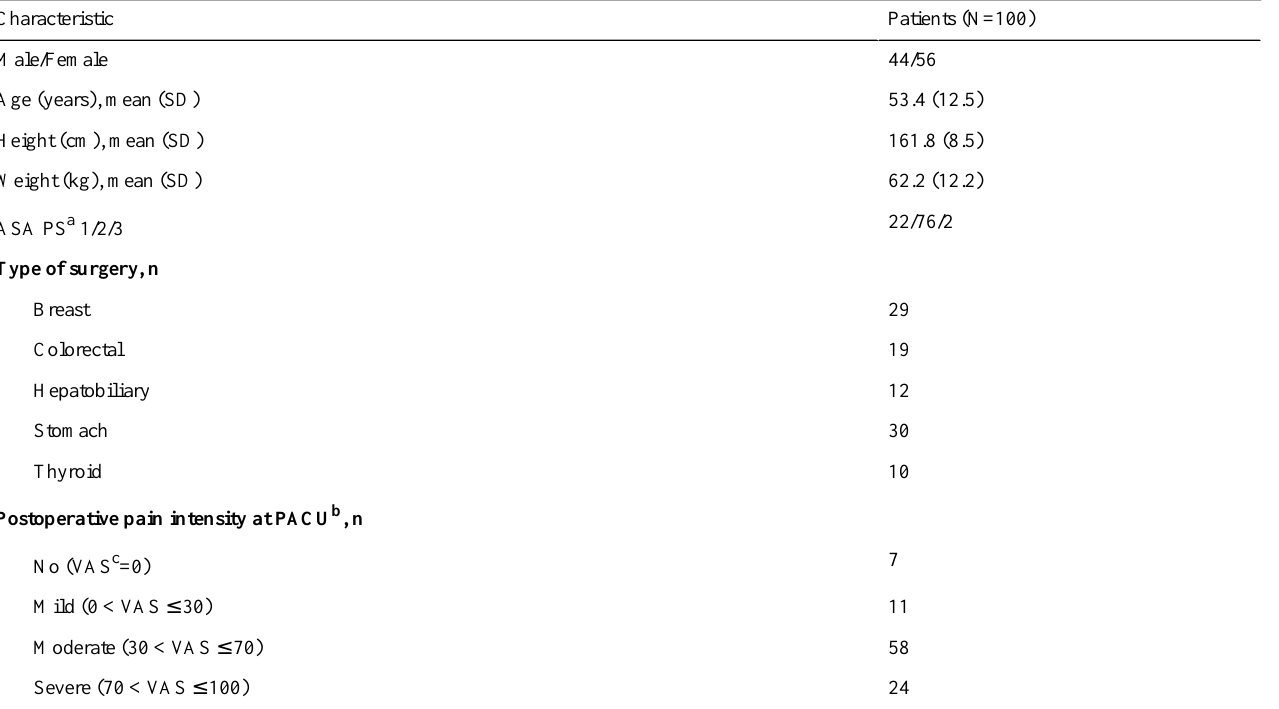
Table 1. Characteristics of the study population.